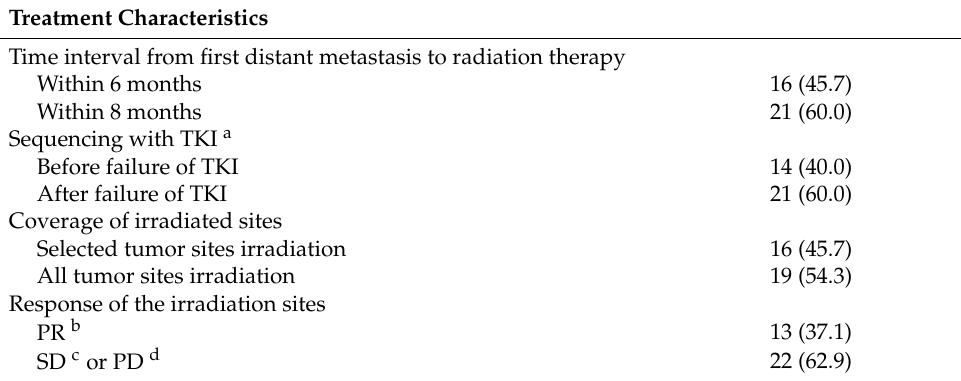
Table 2. Treatment characteristics that correlated with radiation